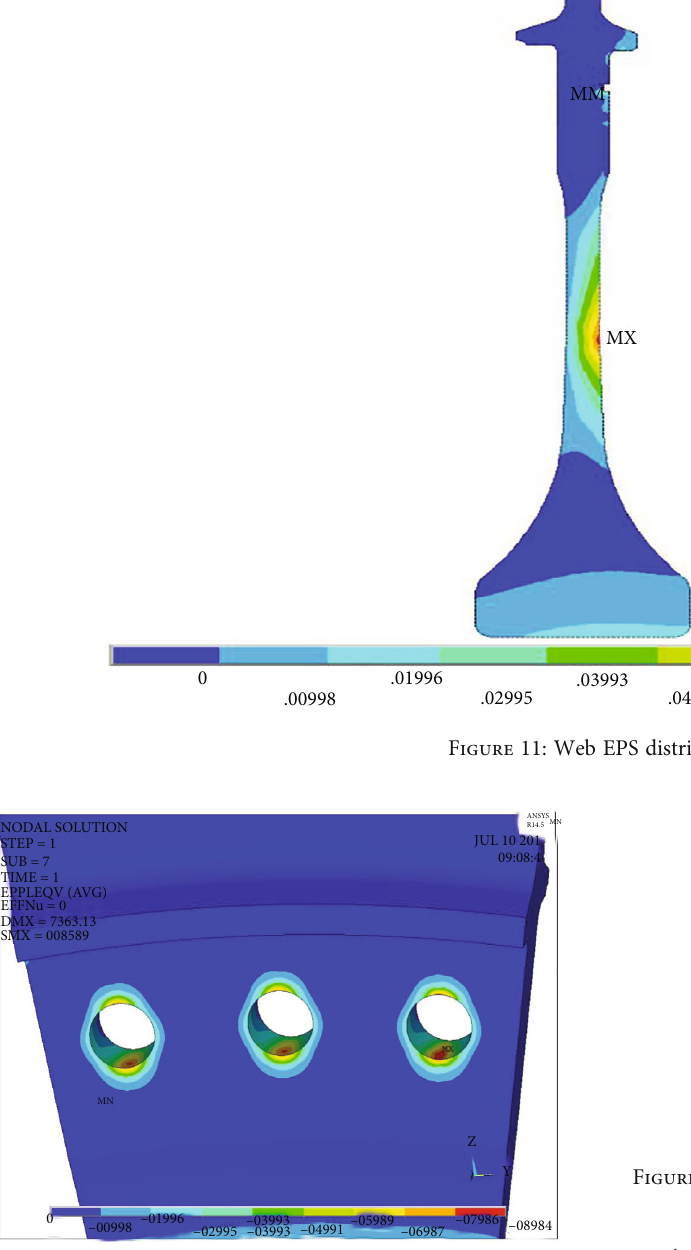
Figure 12: Bolt hole EPS distribution.